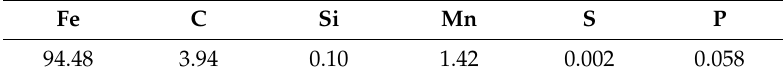
Figure 15. The SEM micrographs ( a ) and energy dispersive X-ray spectroscope (EDS) spectrums ( b ) of the iron nugget obtained at the optimal condition. Table 3. Energy dispersive X-ray spectroscope (EDS) results of the iron nuggets obtained at the optimal condition.